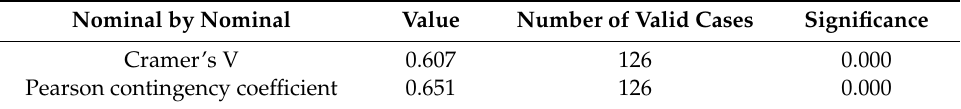
Table 4. Cramer’s V and Pearson contingency coe ffi